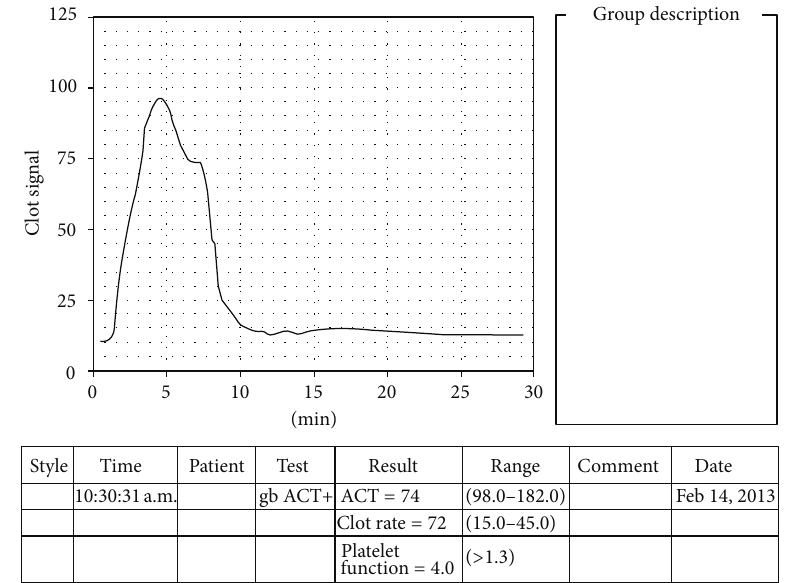
Figure 4: Hypercoagulability (ACT of sample < ACT normal range, CR of sample ≫ CR normal range). The steep slope of the signature is depicted by increased clot rate (72 units/min). The characteristic rise of the graph (as seen by increased peak amplitude) and sharp peak depict strong clot retraction by platelets. Note also the time to peak which is very short ( < 5 minutes). The platelet function is very good (as calculated by the R3